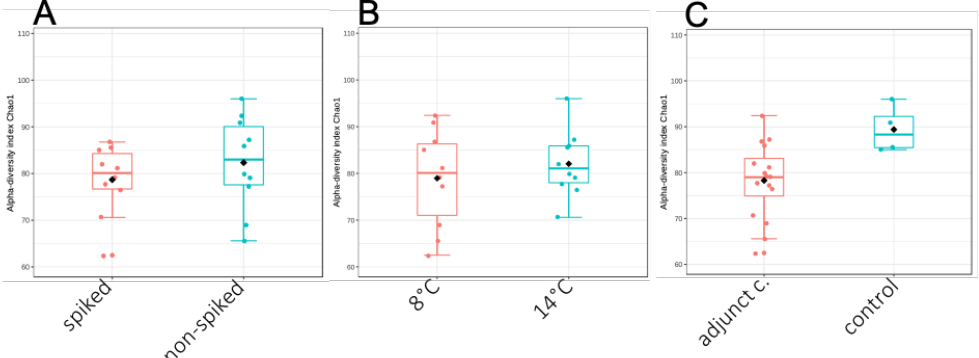
Figure 4. Alpha diversity of cheese samples comparing spike and non-spiked samples ( A ) cheese stored at 8 and 14 °C ( B ) and cheese with and without the adjunct cultures ( C ). Alpha-diversity measured by detected species and Chao1 diversity Index is plotted. The line inside the box represents the median, while the whiskers represent the lowest and highest values within the 1.5 interquartile range. Outliers and individual sample values are shown as dots.